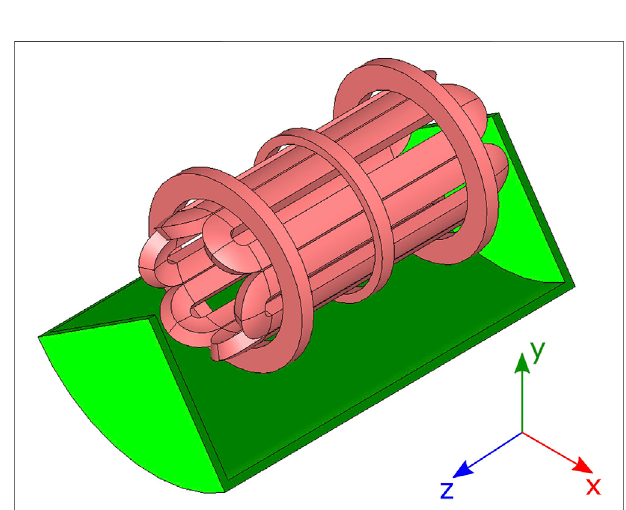
FIGURE 2 | 3D conceptual model of the structure comprehensive of the magnetic system (pale red objects) and the iron yoke (green object, only 1/4 visible).